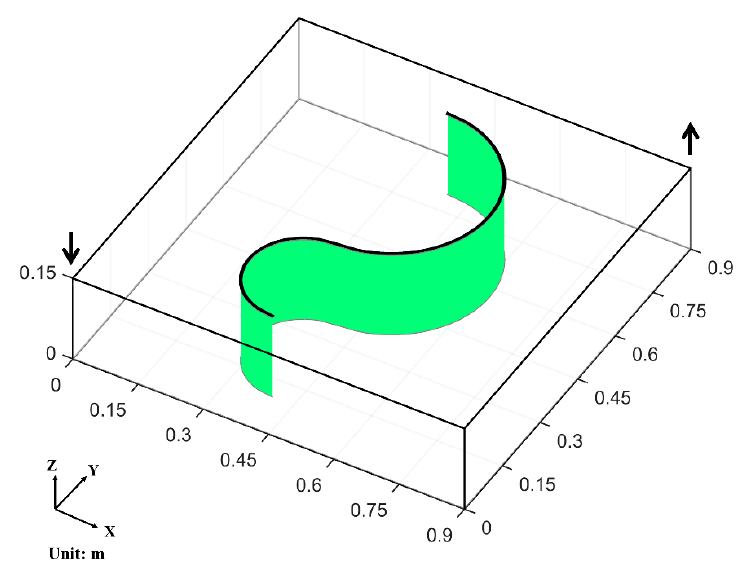
Figure 11. The nonplanar-fractured reservoir in Case 3. A water injector (8.64 × 10 − 5 m 3 /day) is located in one corner of the reservoir, and a producer is placed in the opposite corner.